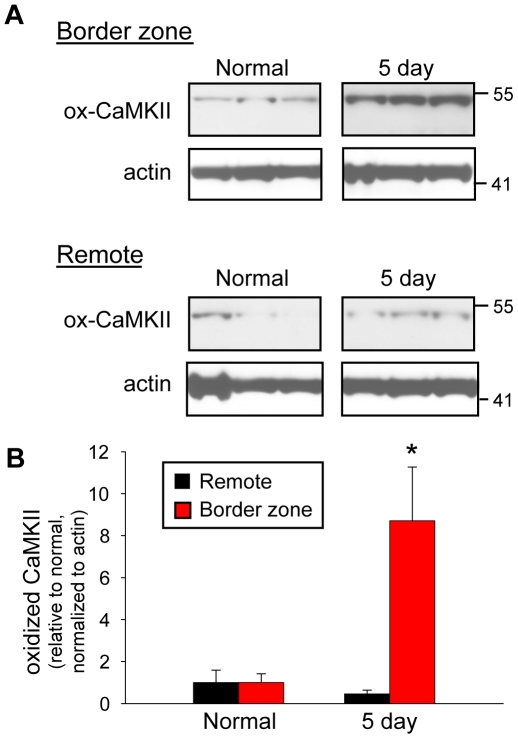
Increased levels of oxidized CaMKII following myocardial infarction.(A) Representative immunoblots and (B) densitometric measurements (normalized to actin and expressed relative to normal levels) of oxidized CaMKII from remote and BZ regions of normal and infarcted hearts. Error bars designate standard deviation (*p<0.01 compared to normal BZ or remote, n = 4).